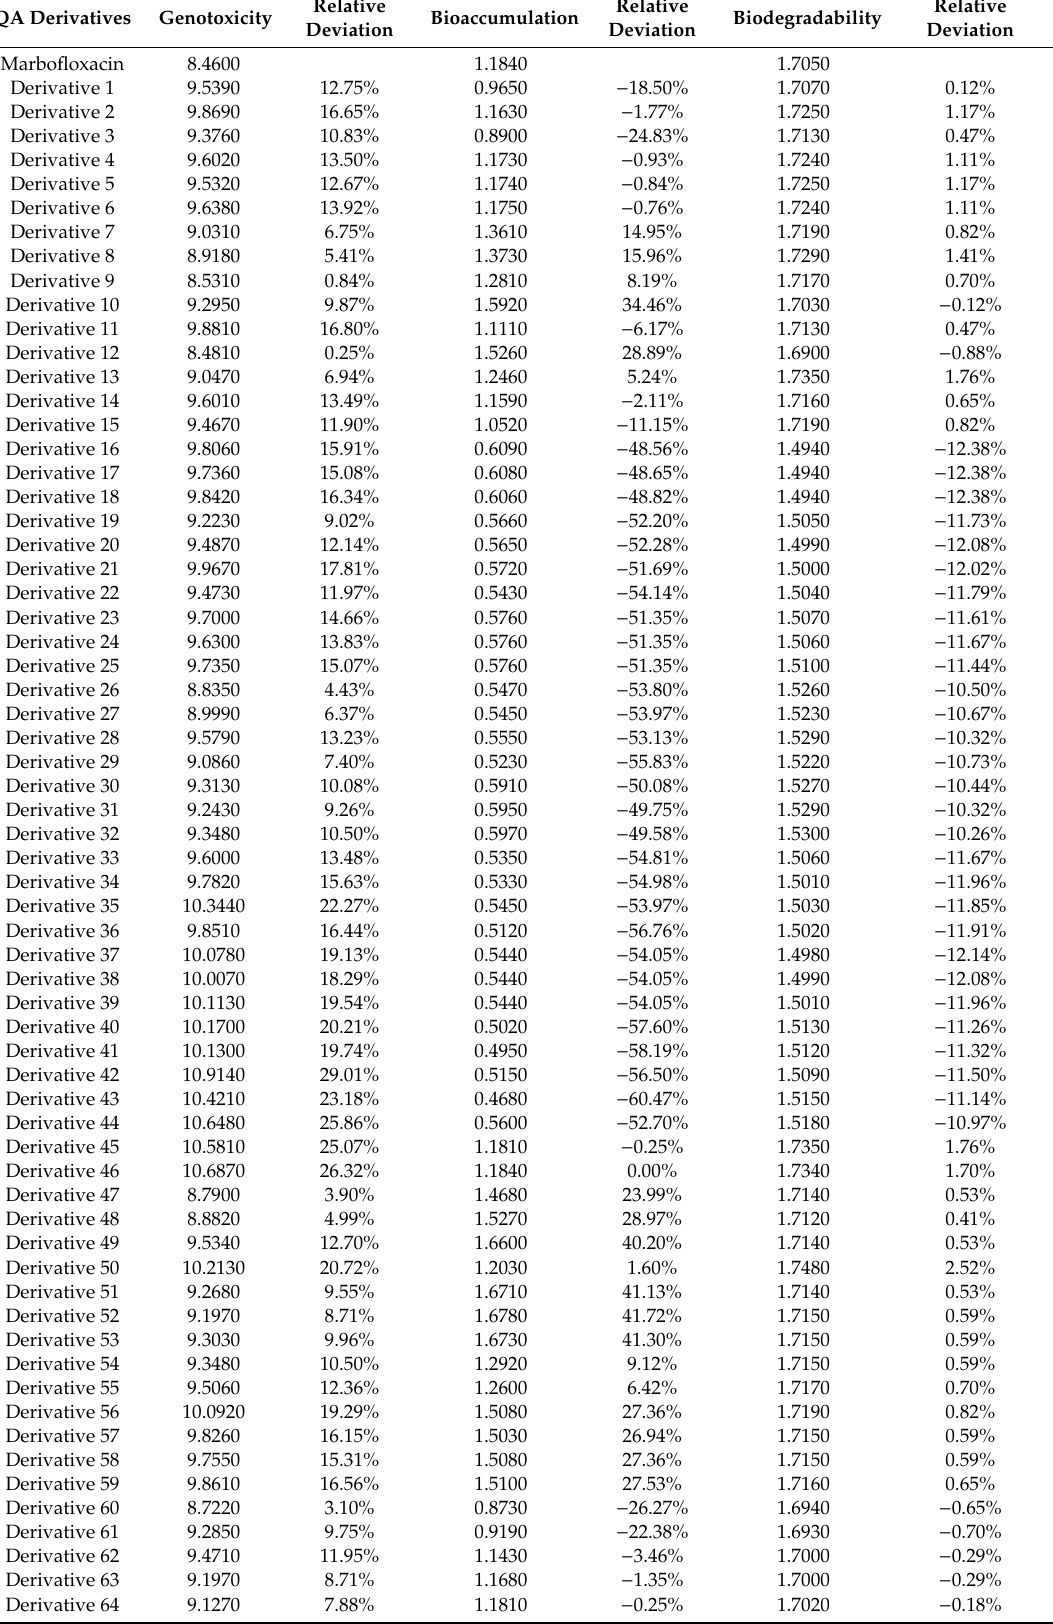
Table 9. Predicted results of genotoxicity, bioaccumulation, and biodegradability of 87 QA